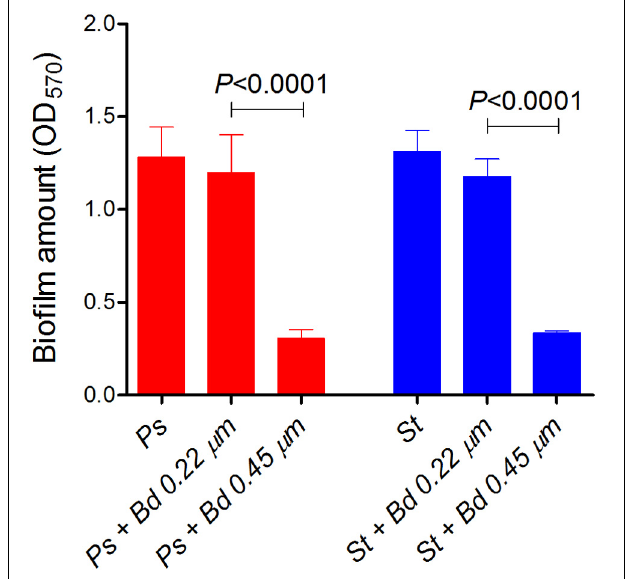
FIGURE 3 | Predation of B. bacteriovorus on “static” prey biofilm. Biofilm of P. aeruginosa (Ps, red) and S. aureus (St, blue) were grown on 48-well plates for 24h, and challenged with B. bacteriovorus for additional 24h. After crystal-violet staining, OD 570 nm was used to measure biofilm amount, and Wilcoxon Signed Rank test was used to assess statistical